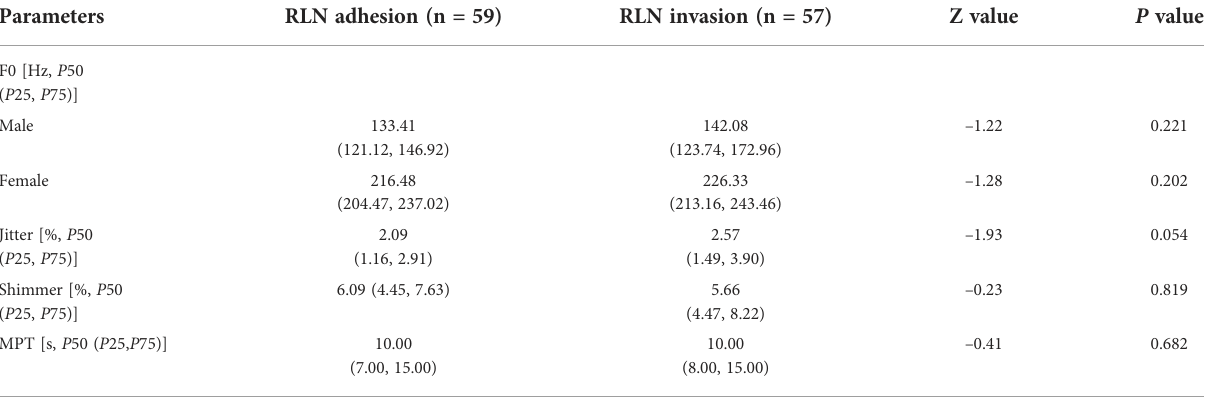
TABLE 3 Acoustic parameters of PTC patients with RLN invasion and adhesion.